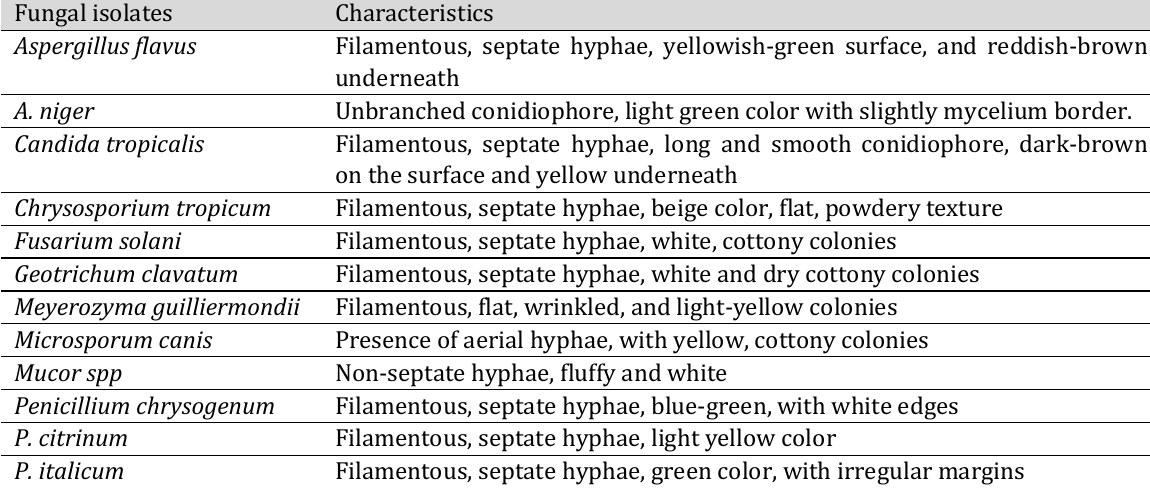
Table 5. Characteristics of the fungal isolates from the palm fruits and palm oil.